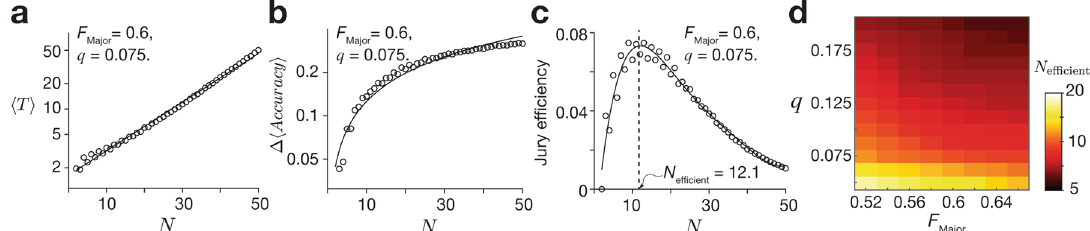
Fig. 2 Brute-force search for ef fi cient jury size. In an example case ( F Major = 0.6 and q = 0.075), the deliberation time 〈 T 〉 and verdict accuracy change Δ 〈 Accuracy 〉 increased along with the jury size N ( a and b ), and the jury ef fi ciency showed a peak at N = 12.1 ( c ). The y -axes in the panels a and b are in a logarithmic scale. We conducted such a search for N ef fi cient in a brute-force manner in broader ranges of F Major and q